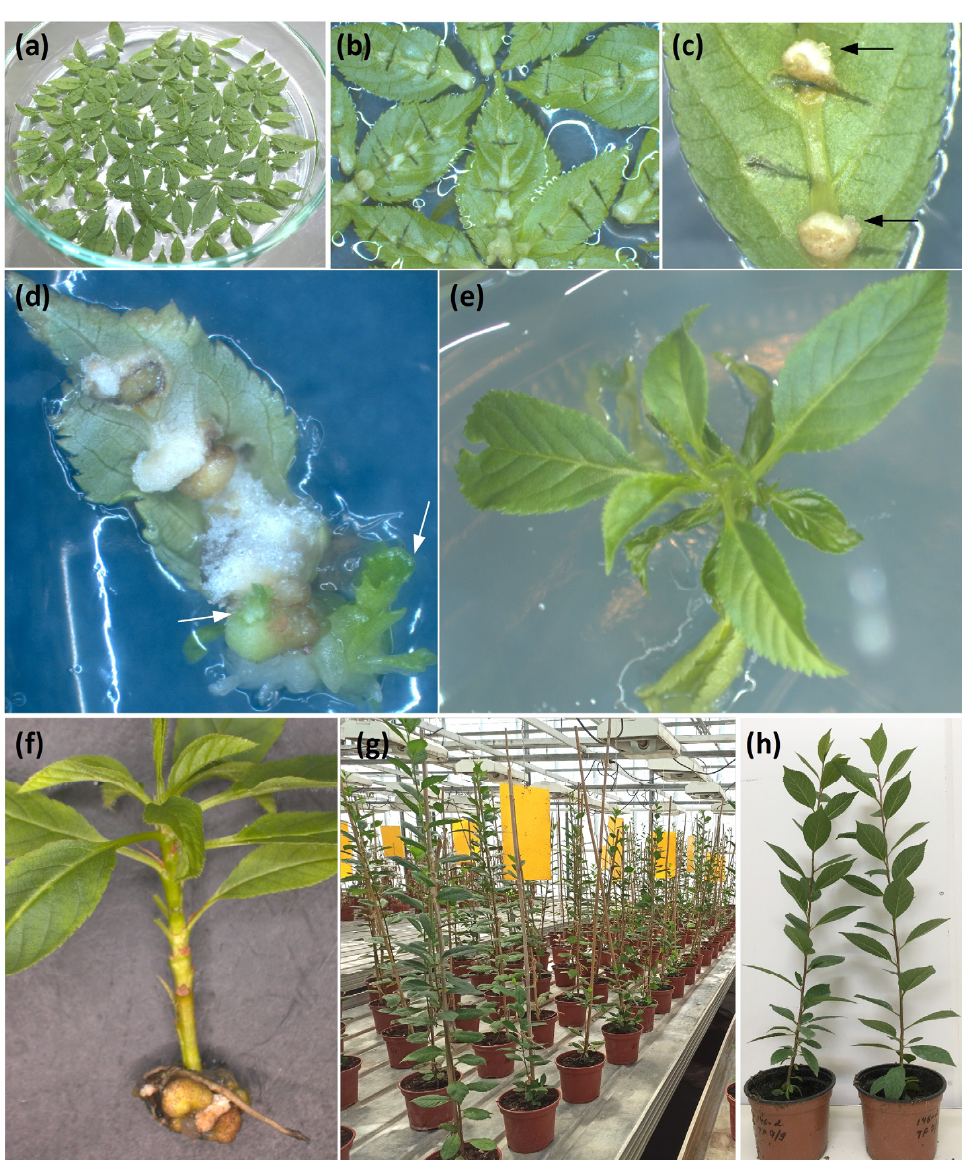
Figure 2. The generation of transgenic 146-2 rootstock plants. ( a ) Rootstock leaf explants in a Petri dish after co-cultivation with Agrobacterium Tumefaciens; ( b ) Callus induction on the leaf explants; ( c ) buds formation on the leaf explants of 146-2 rootstock after 7 days in darkness (marked with arrows); ( d ) formation of leaf-like cluster (marked with arrows); ( e ) elongated transgenic shoot; ( f ) rooted rootstock shoot on a medium with kanamycin; ( g ) establishment of transgenic plum rootstock in the greenhouse; ( h ) transgenic plants of rootstock 146-2 before PPV infection experiment.